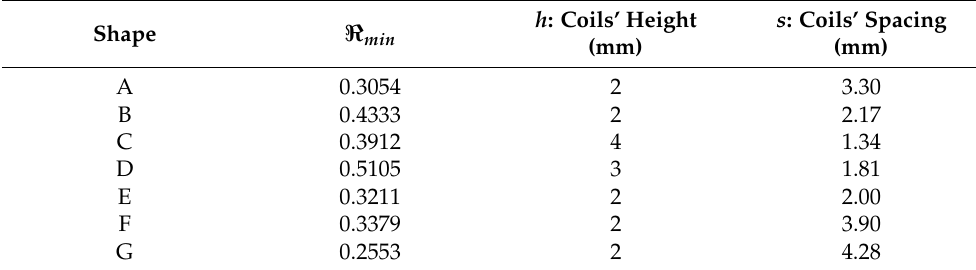
Table 1. Global optimization results with the number of coils are fixed to 6 coils in the probe. The only parameters to optimize are the coils’ spacing and the height of the